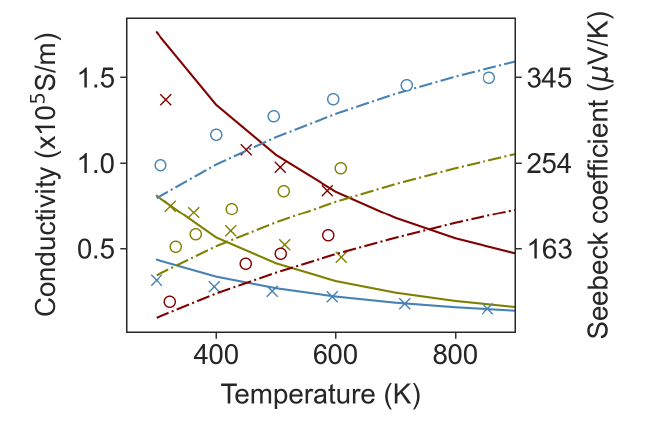
Figure 5. Comparison of the model prediction (lines) of electrical conductivity and thermopower in Si 0.7 Ge 0.3 with experimentally reported results (markers). The measured and predicted electrical conductivity are shown with crosses and solid lines, respectively, and the measured and predicted Seebeck coefficients with circles and dashed lines. The data is for three different doping levels that have carrier concentrations of 1.45 × 10 20 1/cm 3 (red), 6.75 × 10 19 1/cm 3 (blue) and 2.2 × 10 19 1/cm 3 (green). The experimental data are taken from reference [63]. The overall agreement is good, although the model gives a small systematic underestimate of the Seebeck